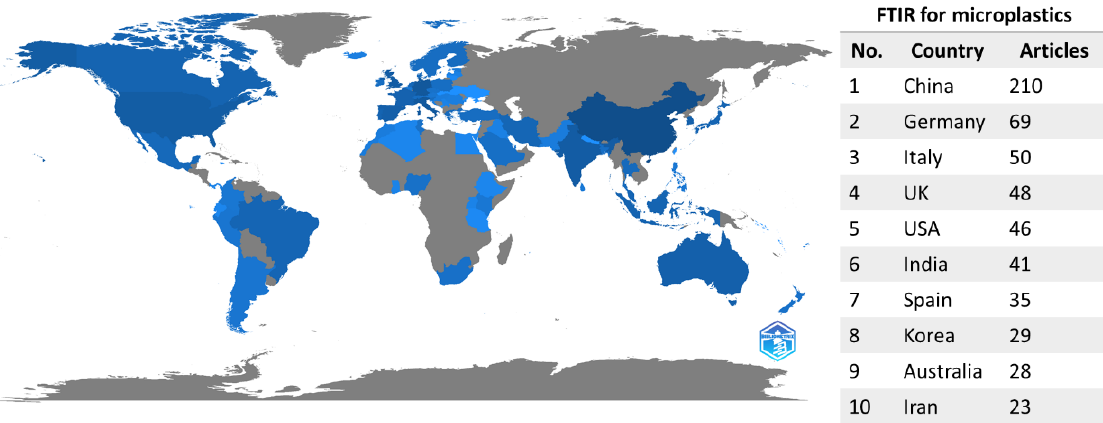
Figure 4. Scientific production by country-NIR related Literature. The map was using the open- source tool Biblioshiny for Bibliometrix [38]. Different shades of blue indicate different productivity rate: dark blue = high productivity; grey = no articles. Number of documents is listed per corre- sponding author’s countries. 3.5. Quality of Publications The most recent references with the highest citation frequency may be useful in ex- amining the research frontiers’ knowledge base. According to the present analysis (without cleaning repetitions of author names), 4421 authors have contributed to the MP research by using the FTIR method, while 193 authors have contributed to the emerging NIR technology in MP analysis. The top 10 cited documents worldwide and their authors are shown in Figure 5. Citation in scientific pa- pers is another important sign of a paper’s quality and influence. The number of citations has long been considered a barometer of a country’s scientific research performance.